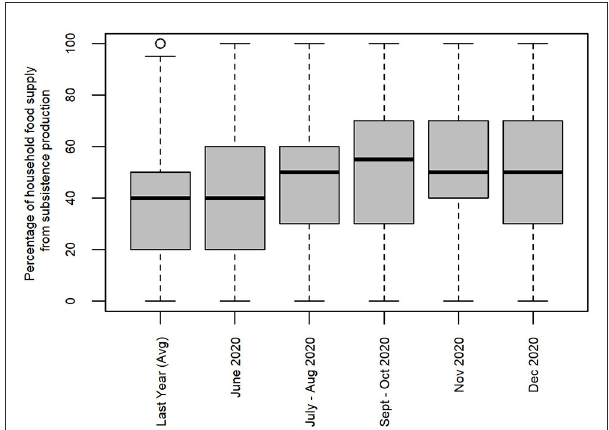
FIGURE3 Subsistence food consumption before and during pandemic. Boxplot showing the proportion of household food derived from subsistence production compared to other sources (market and